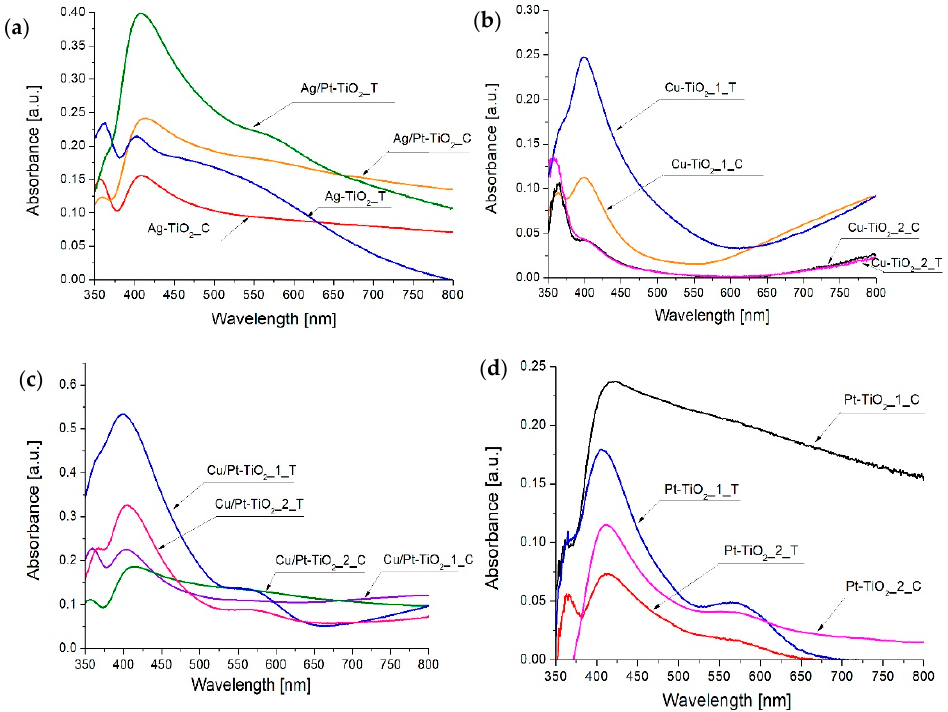
Figure 1. Absorption spectra of ( a ) Ag-TiO 2 _C, Ag-TiO 2 _T, Ag / Pt-TiO 2 _T and Ag / Pt-TiO 2 _C ( b ) Cu-TiO 2 _1_C, Cu-TiO 2 _2_C, Cu-TiO 2 _1_T and Cu-TiO 2 _2_T, (c) Cu / Pt-TiO 2 _1_C, Cu / Pt-TiO 2 _2_C, Cu / Pt-TiO 2 _1_T and Cu / Pt-TiO 2 _2_T, ( d ) Pt-TiO 2 _1_C, Pt-TiO 2 _2_C, Pt-TiO 2 _1_T and Pt-TiO 2